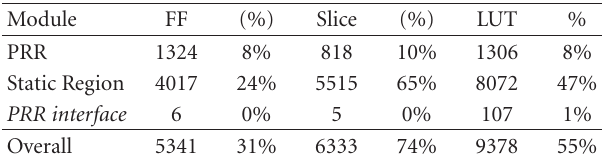
Table 3: Hardware utilization of Virtex-4 XC4VFX20-11FF672 for full-filter reconfiguration.